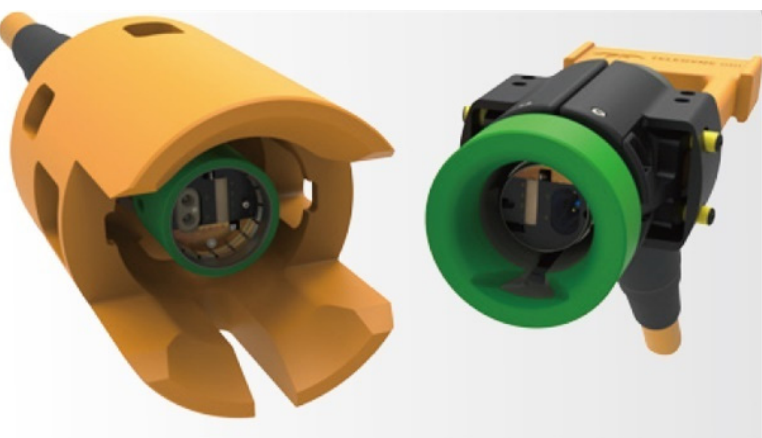
Figure 6. The Nautilus TM NRH hybrid WMC [40].